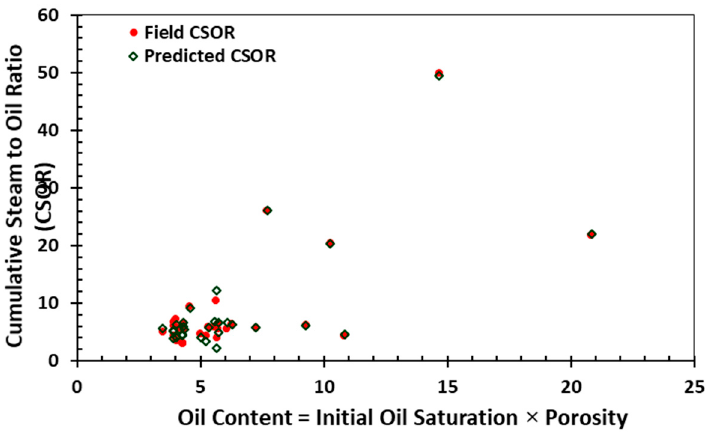
Figure 8. CSOR vs. oil content for the database Figure 7. CSOR vs. oil content for the database analyzed. Figure 7. CSOR vs. oil content for the database analyzed.